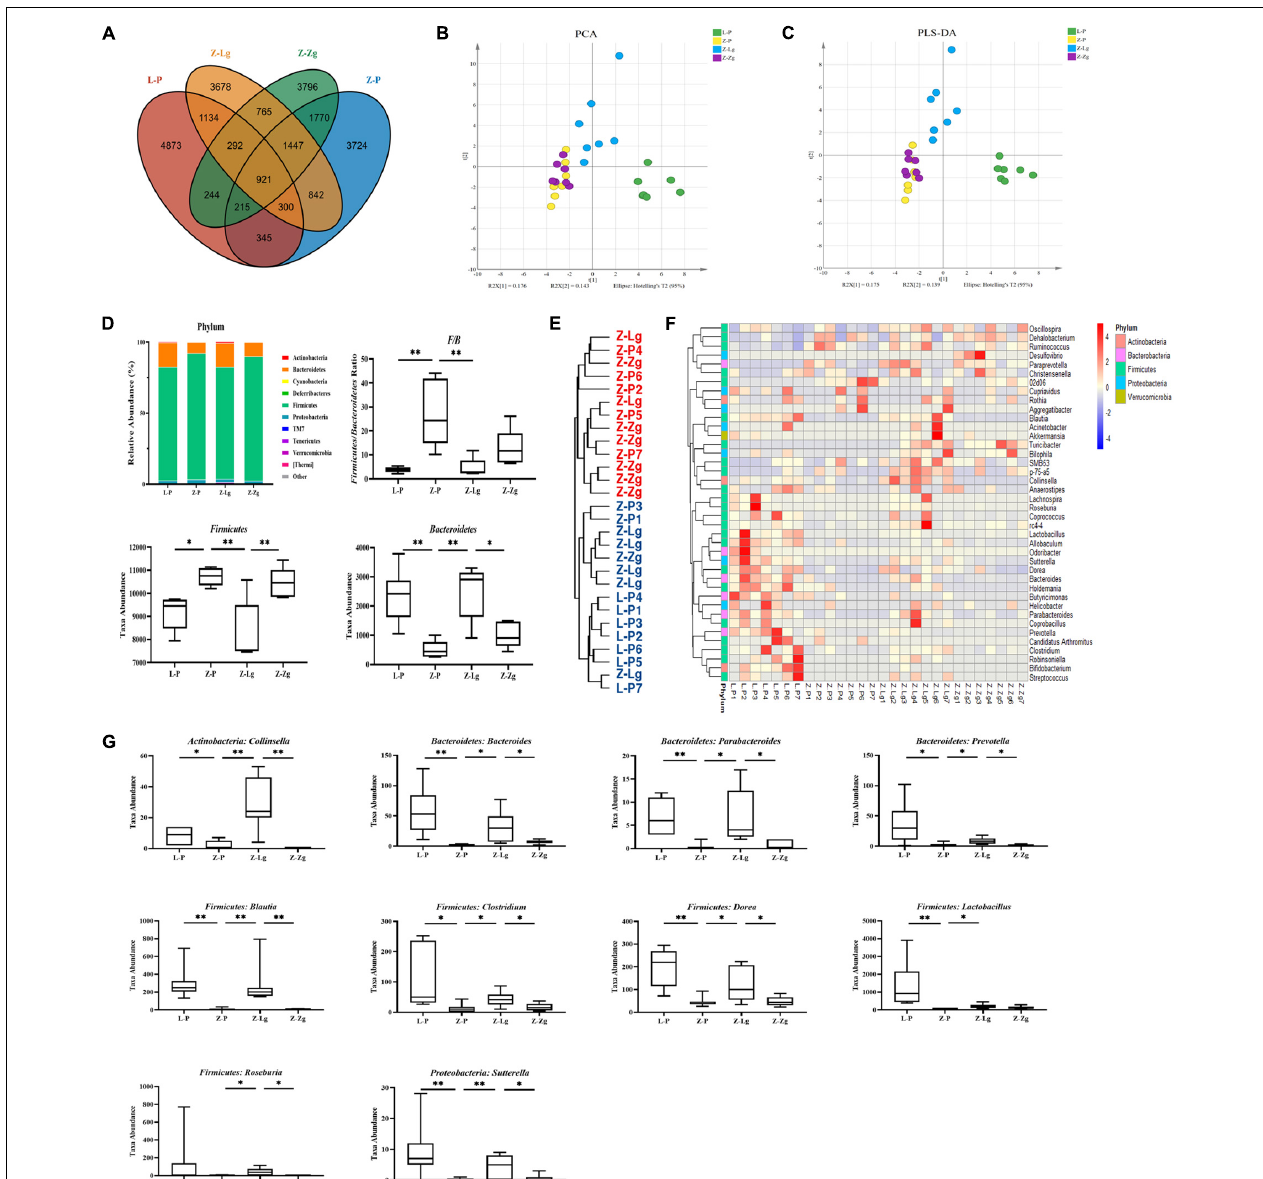
FIGURE 6 | GMT changes gut microbial composition in ZDF recipient rats. (A) The number of OTUs that are distinct and shared across the groups by Venn diagrams. (B,C) Microbiota community analysis based on PCA and PLS-DA score plots. (D) Bacterial taxonomic composition profiling of gut microbiota at the phylum level [ F/B : F ( 3 , 16 ) = 8.758, P = 0.0011; Firmicutes : F ( 3 , 16 ) = 8.744, P = 0.0012; Bacteroidetes : F ( 3 , 17 ) = 9.512, P = 0.0006]. (E) Phylogenetic tree map of the bacterial at the genus level. (F) Hierarchical clustering heatmap of the top 50 differentiated taxa at the genus level. (G) Abundance of the key differentiated taxa in different groups [ Collinsella : F ( 3 , 24 ) = 14.75, P < 0.0001; Bacteroides : F ( 3 , 22 ) = 6.924, P = 0.0019; Parabacteroides : F ( 3 , 23 ) = 7.297, P = 0.0014; Prevotella : F ( 3 , 21 ) = 5.323, P = 0.0069; Blautia : F ( 3 , 24 ) = 8.530, P = 0.0005; Clostridium : F ( 3 , 22 ) = 5.186, P = 0.0073; Dorea : F ( 3 , 23 ) = 9.372, P = 0.0003; Lactobacillus : F ( 3 , 21 ) = 5.360, P = 0.0067; Roseburia : F ( 3 , 24 ) = 1.438, P = 0.2564; Sutterella : F ( 3 , 24 ) = 5.924, P = 0.0036]. Data are shown as mean ± SD ( n = 5–7 per group). ∗ P <0.05, ∗∗ P <0.01. One-way or two-way ANOVA, followed by Tukey’s post-hoc test. OTUs, operational taxonomic units; PCA, principal component analysis; PLS-DA, partial least squares discriminant